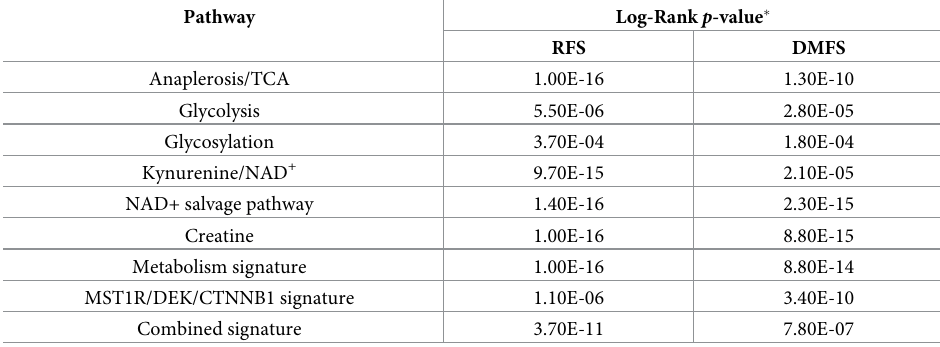
Table 2. Metabolic pathways and signatures with prognostic capacity. Pathways and signatures displayed with respective relapse-free survival (RFS) and distant metastasis-free survival (DMFS) P-values.